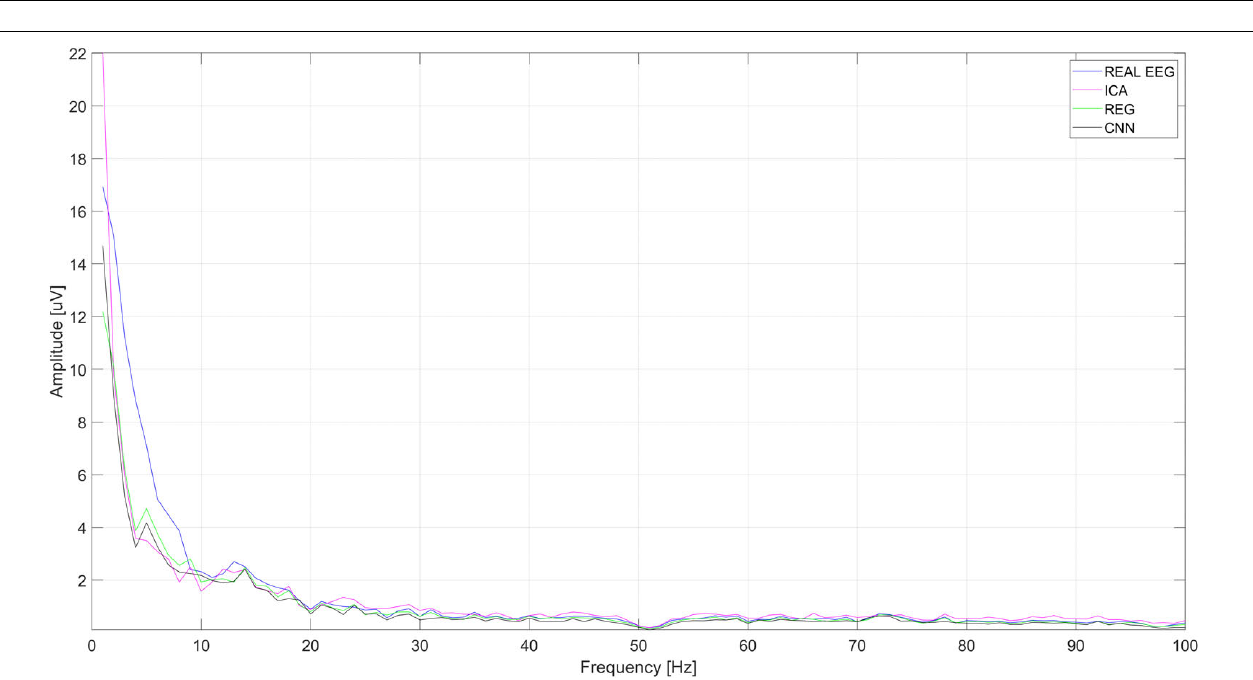
central part of the head. To verify the usefulness of the method to eliminate eye blink artifacts, we cleared the EEG signals from the Cz electrode for the signals registered during the experiments with the N-back task.